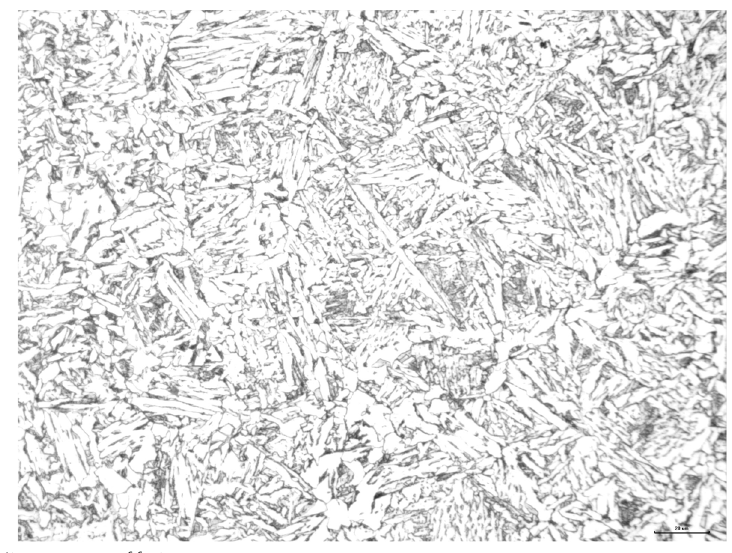
Fig. 6 Microstructure of fusion zone